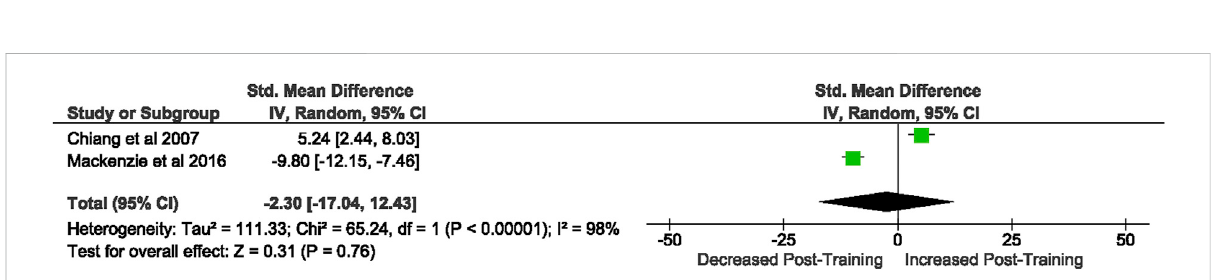
FIGURE 11 Effect of intensi fi ed training on resting dendritic cell MHC II expession. All studies used rodent participants. CI Con fi dence interval.